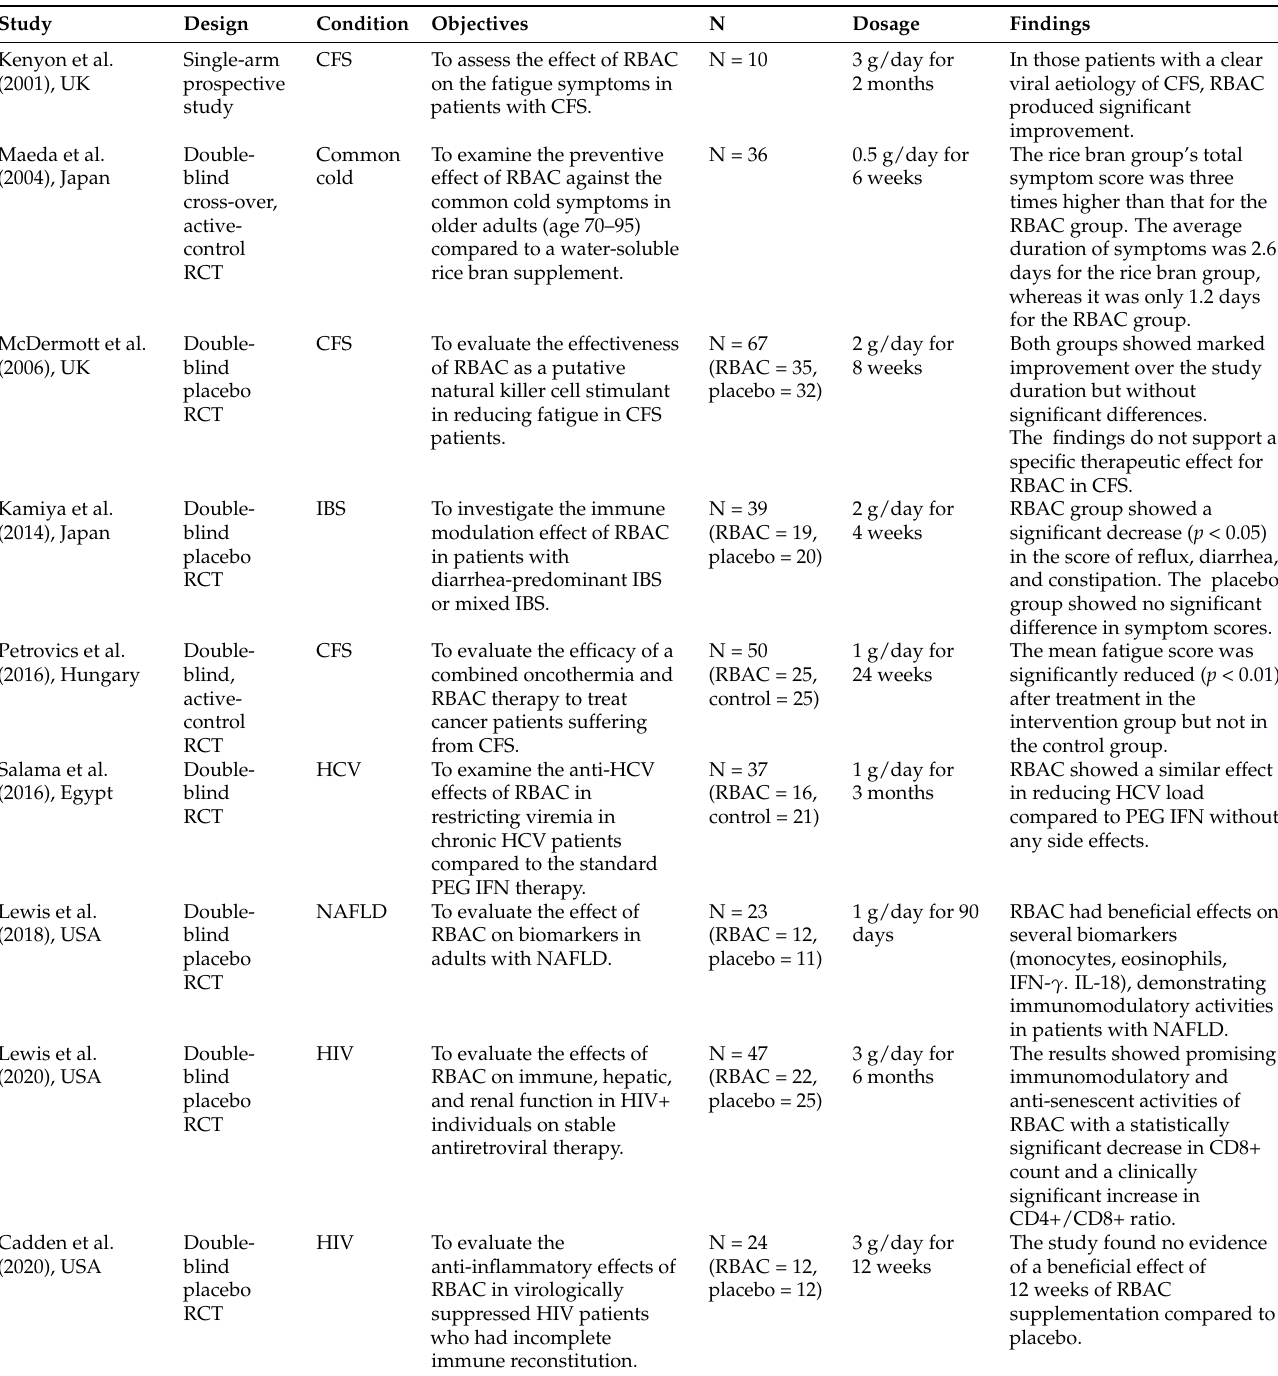
Table 2. Summary of clinical trials evaluating the effects of RBAC on health conditions other than